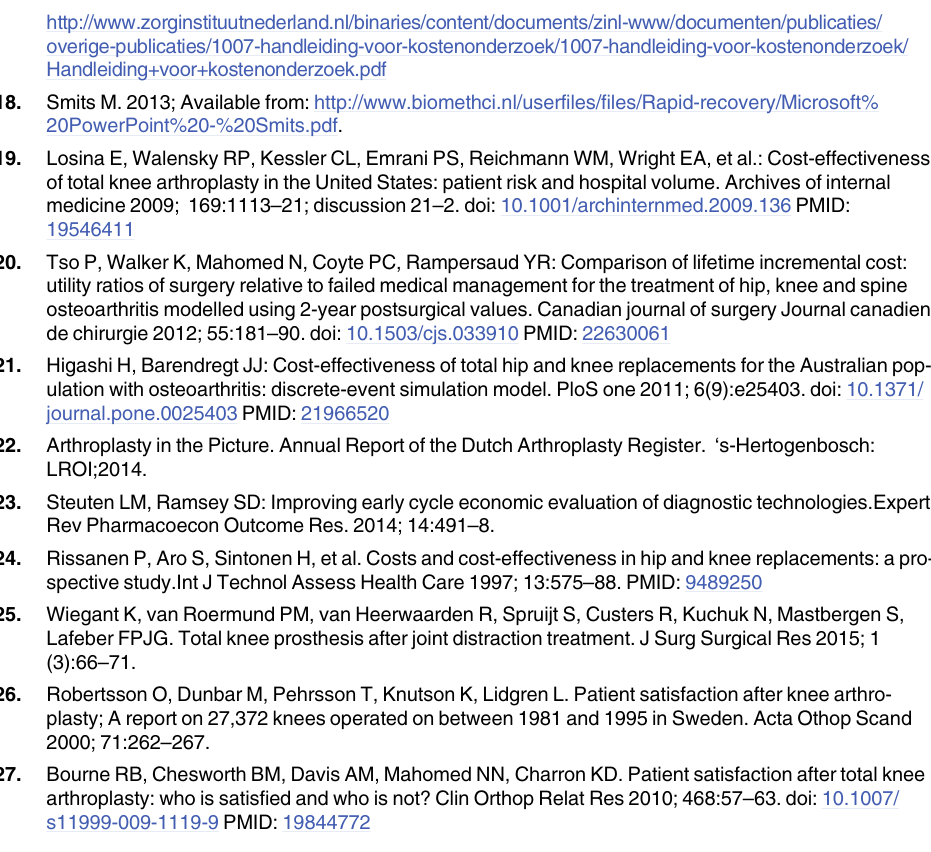
PLOS ONE | DOI:10.1371/journal.pone.0155524 May 12,